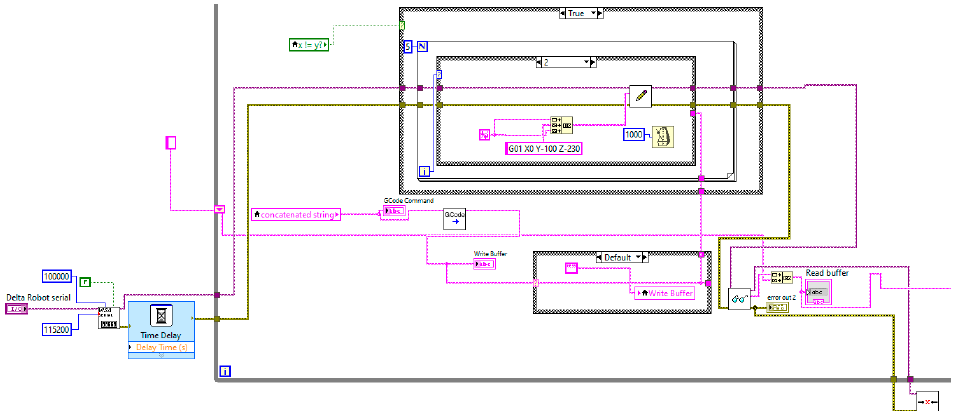
Figure 9. Communication and control software for the Delta X robot.